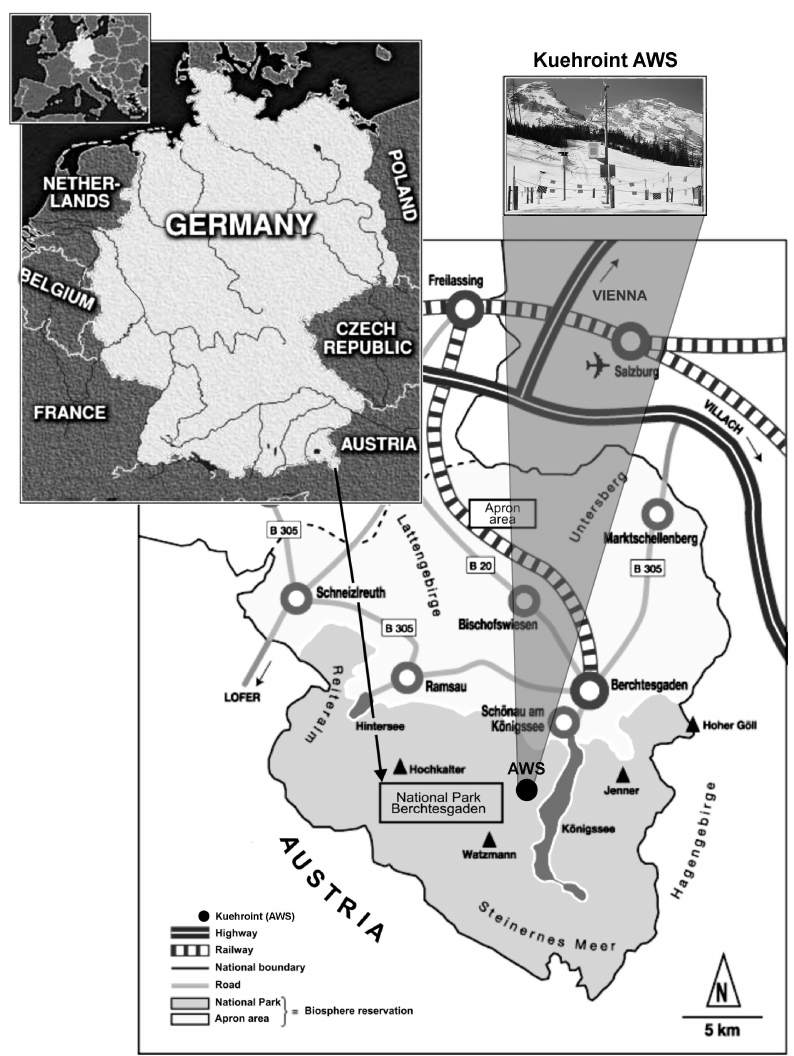
Fig. 1. The location of the Kuehroint site (1407ma.s.l.) in Berchtesgaden National Park